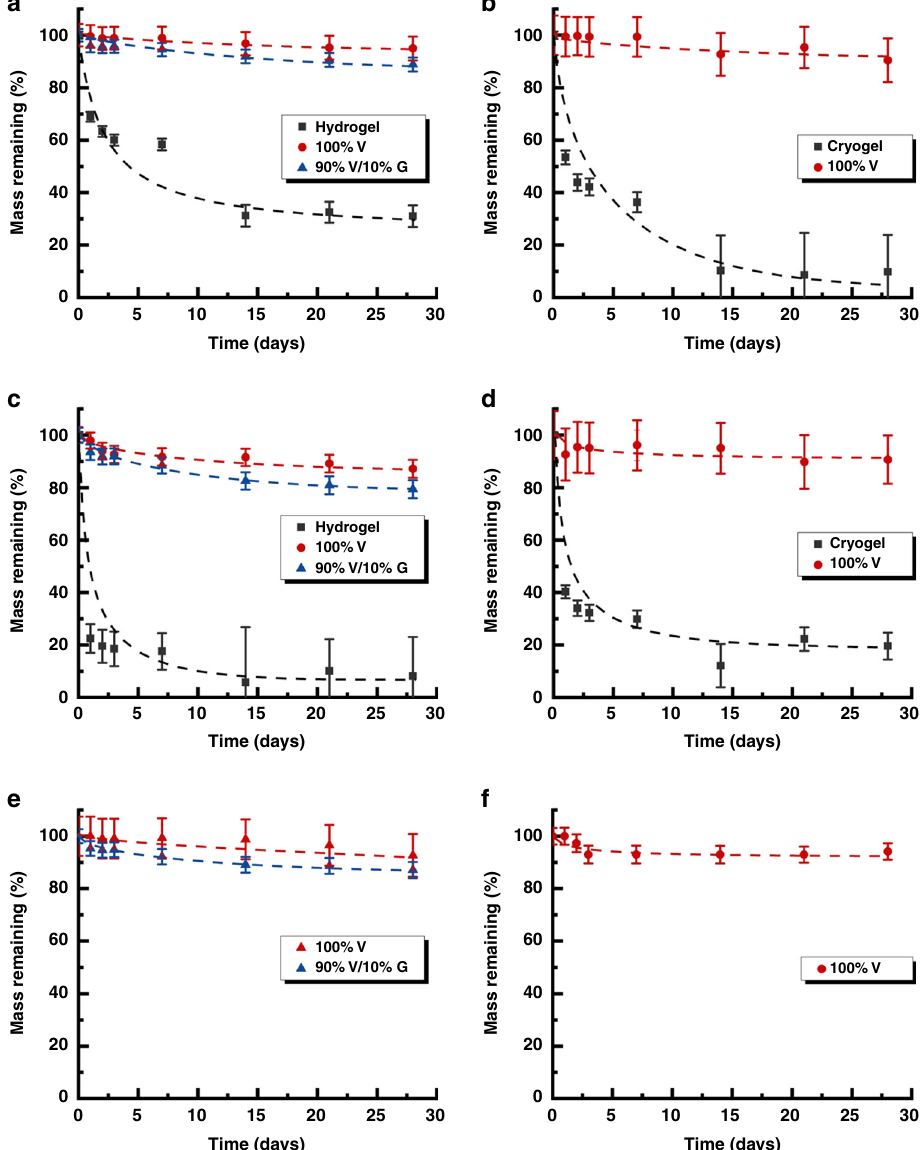
Fig. 8 Degradation pro fi les of β -sheets-incorporated networks in harsh environments. a , c , e Represent hydrogel degradation while b , d , f represents cryogels degradation. a , b Were obtained in 2 M HCl; c , d were obtained in 2 M NaOH and ( e , f ) were obtained in 6 M GdnCl. Error bars determined by experimental